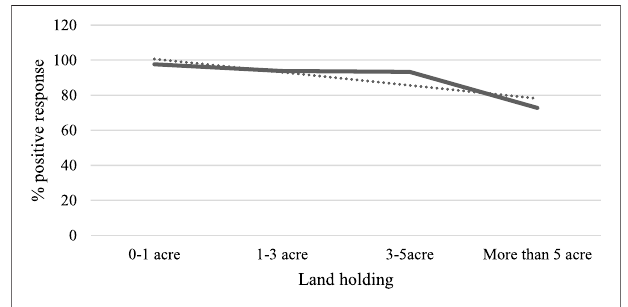
FIGURE 5 | Land Holding vs. Outlook towards afforestation.